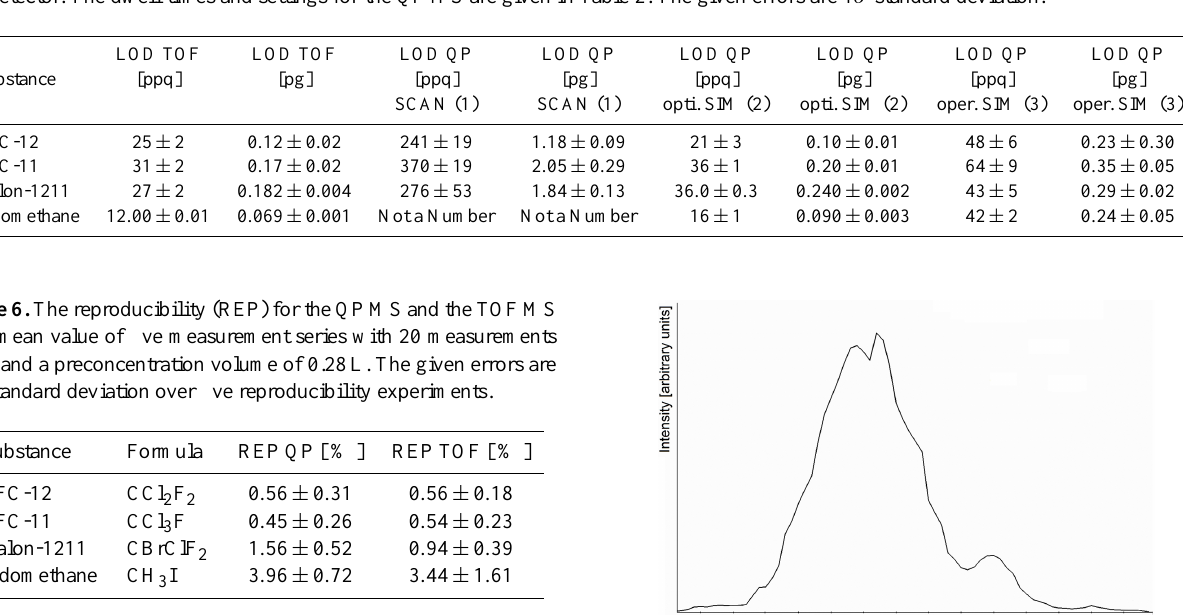
Table 5. The limit of detection (LOD) in ppq and pg of the substances CFC-12, CFC-11, Halon-1211 and Iodomethane in 1L of air sample per detector. The dwell times and settings for the QP MS are given in Table 2. The given errors are 1 σ standard deviation.